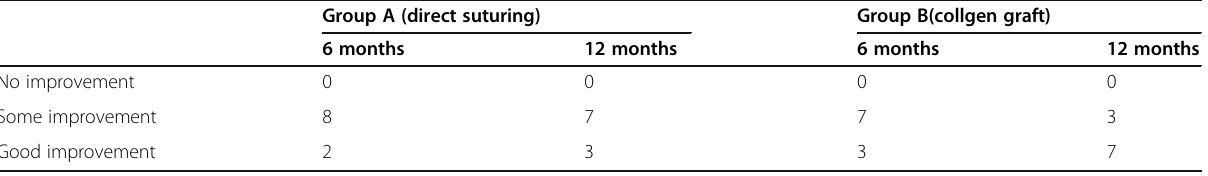
Table 9 Postsurgical outcomes classified by the criteria of Pogrel